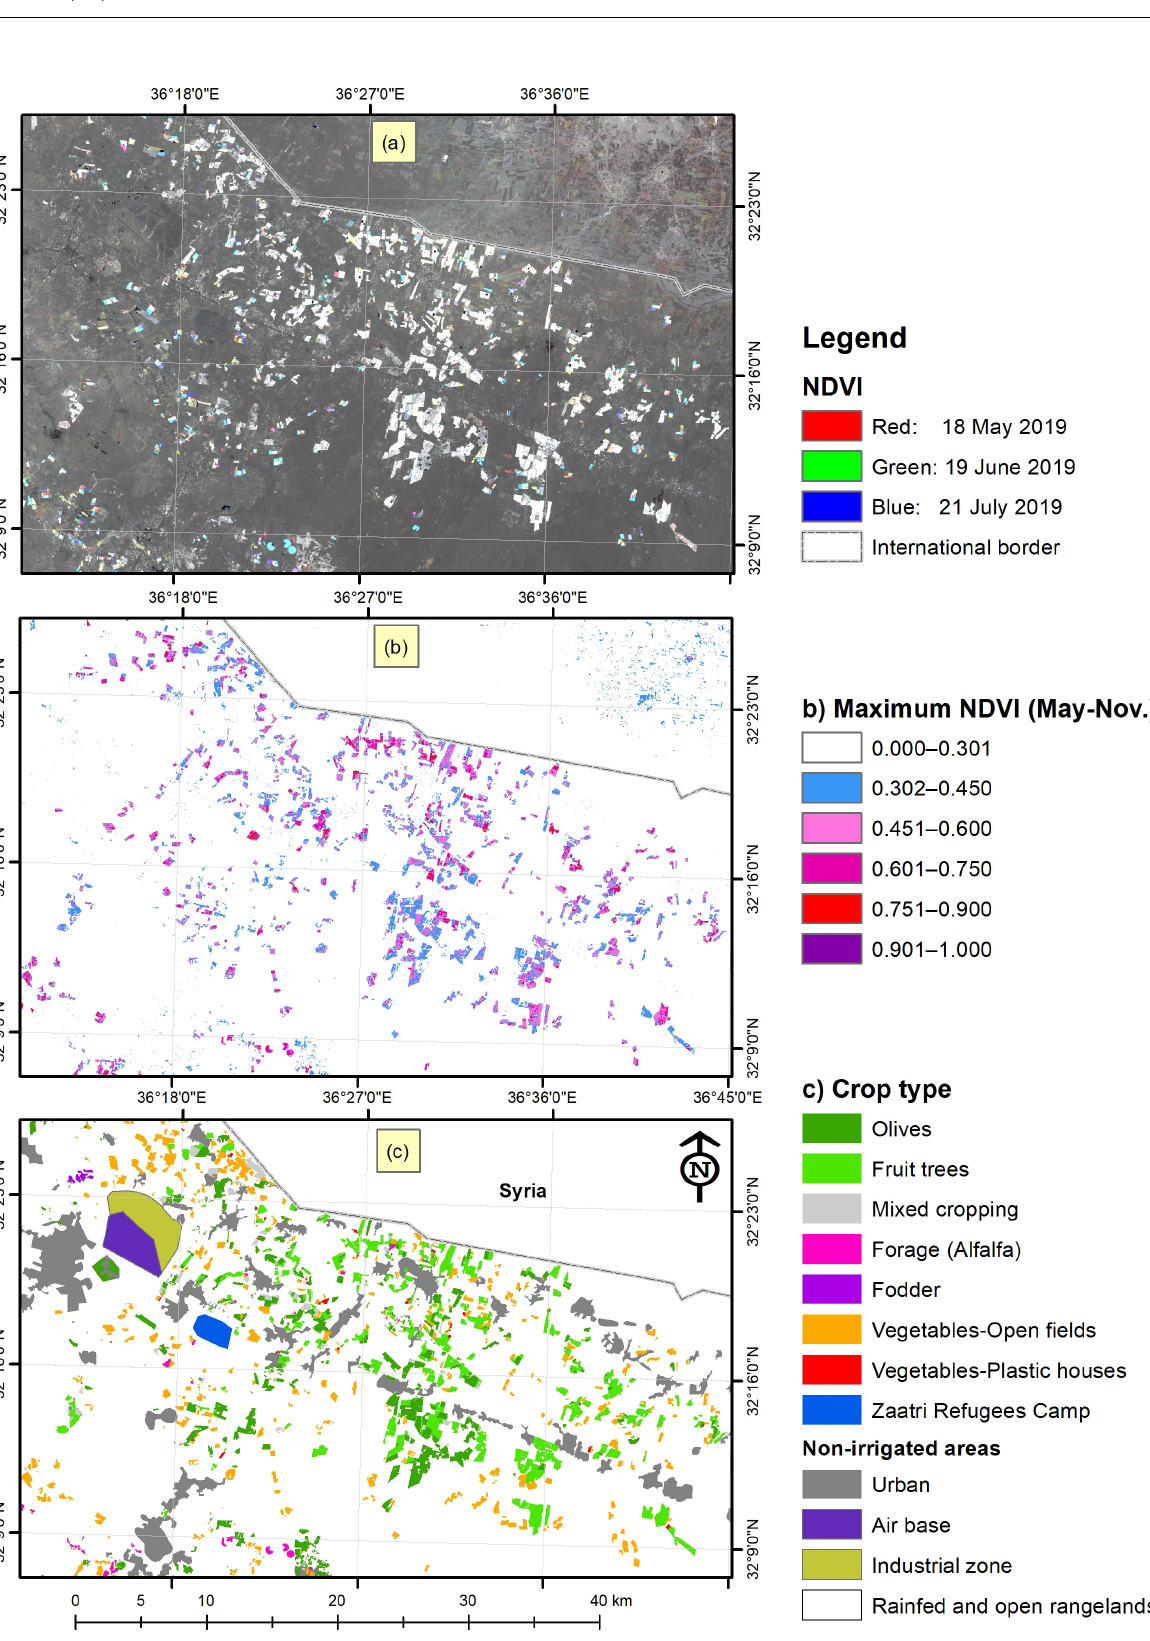
Figure 7. Mapping of irrigated crops in Mafraq. ( a ) Example of the multi-temporal NDVI layers covering the whole year; ( b ) Detection of irrigated parcels through density slicing of maximum NDVI value during May-November; ( c ) Final map of irrigated crops.